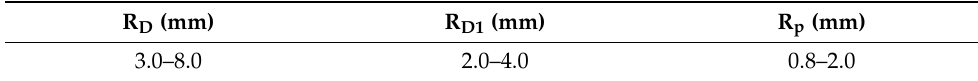
Table 2. Tool parameters in the deep drawing